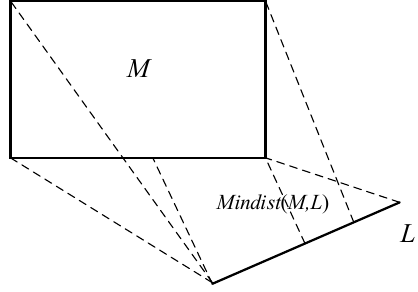
Figure 3. The Mindist between a line segment and a rectangle.